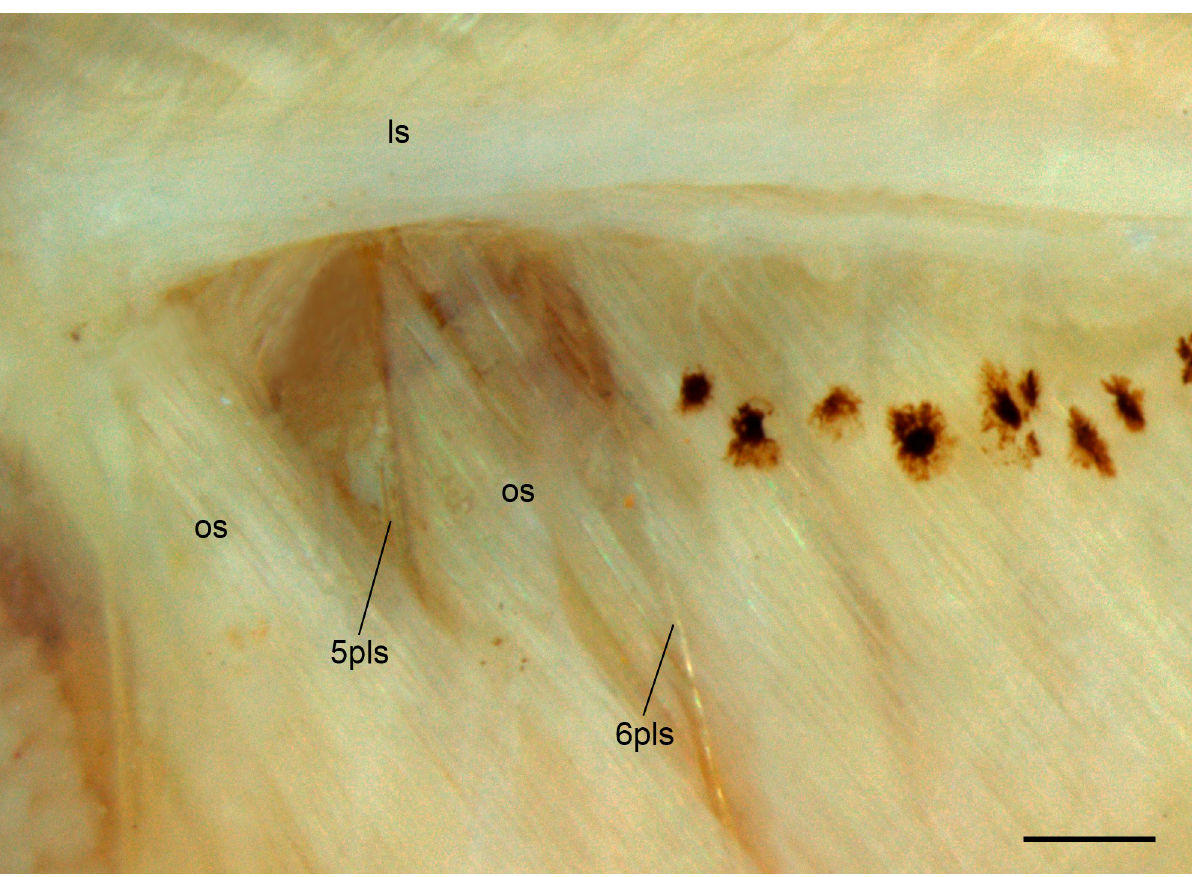
Fig 3. External view of muscle covering the anterior portion of the swim bladder of Tyttobrycon shibattai MZUSP 125269, paratype, mature female, 13.5 mm SL. Skin and adipose tissue removed, left side view. 5plr = fifth pleural rib; 6plr = sixth pleural rib; ls = lateralis superficialis ; os = obliquus superioris